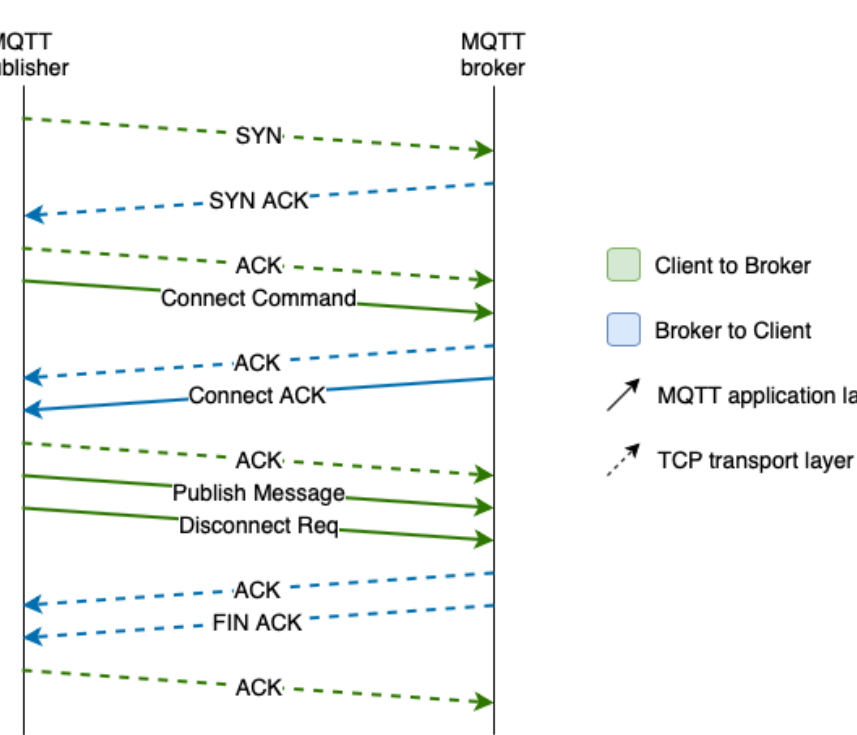
Figure 1. MQTT protocol messages for a MQTT